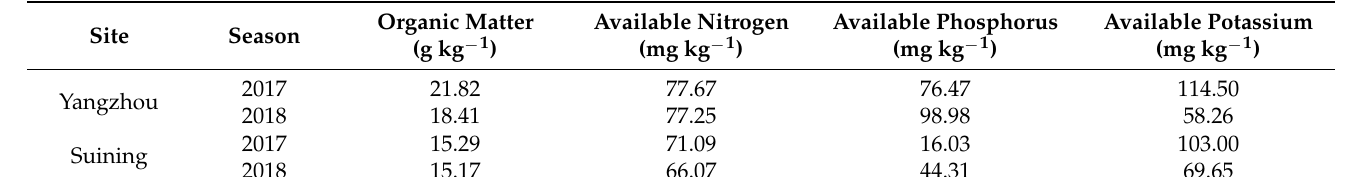
Table 1. Soil nutrient contents in experimental winter wheat fields in the southern (Yangzhou) and northern (Suining) areas of the Yangtze River basin, China, in 2017 and 2018.